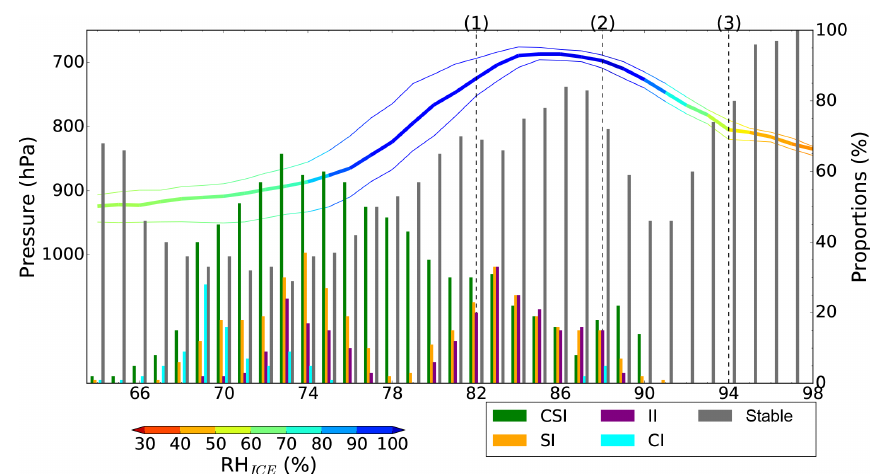
Figure 5. Time series (hours since start of run) of pressure (colours indicate relative humidity with respect to ice) and diagnosis of instability conditions along the trajectories in coloured bars. See Sect. 2.2 for details on instability